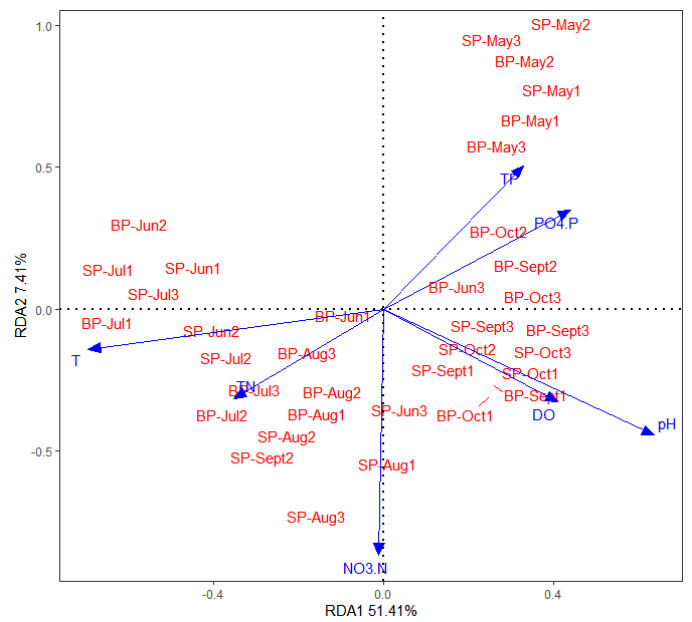
Figure 5. RDA diagram of the relationships between pond microbial composition and environmental factors in different sampling months. The explanatory variables are shown by different arrows. BP, large area pond; SP, small area pond; May–Oct. indicate sampling time; 1, 2, and 3 represent three duplicate ponds.